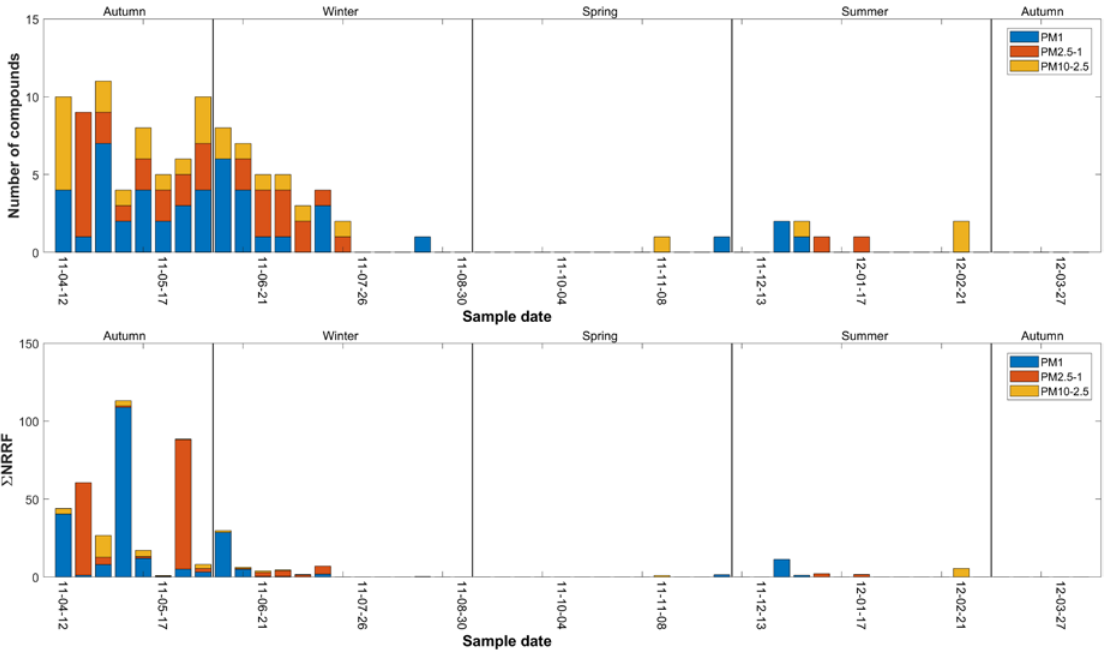
Figure 4. Total number of amides identified and their corresponding semi-quantified concentrations ( Σ NRRFs) in the three particle size fractions for each sample collected.